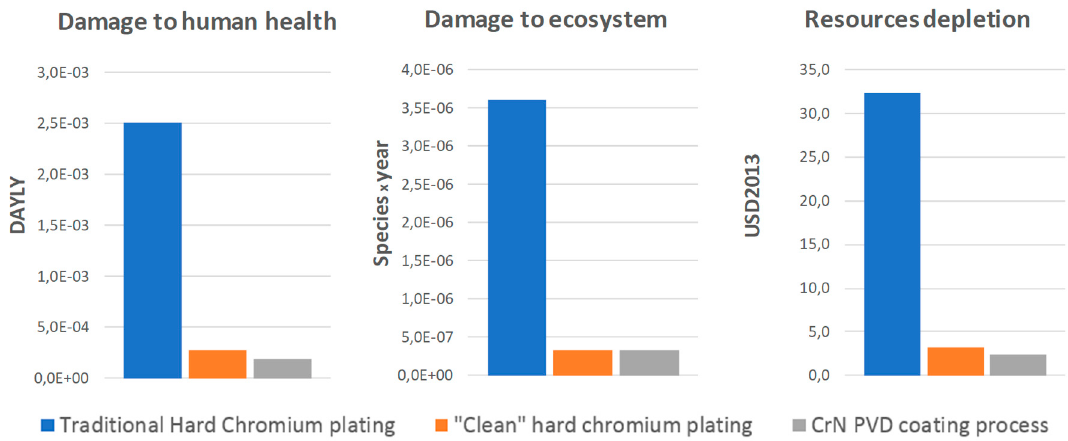
Figure 5. Environmental profile of three coating processes: traditional chrome plating, new clean chrome plating and CrN PVD. Impact evaluation method: ReCiPe [4].